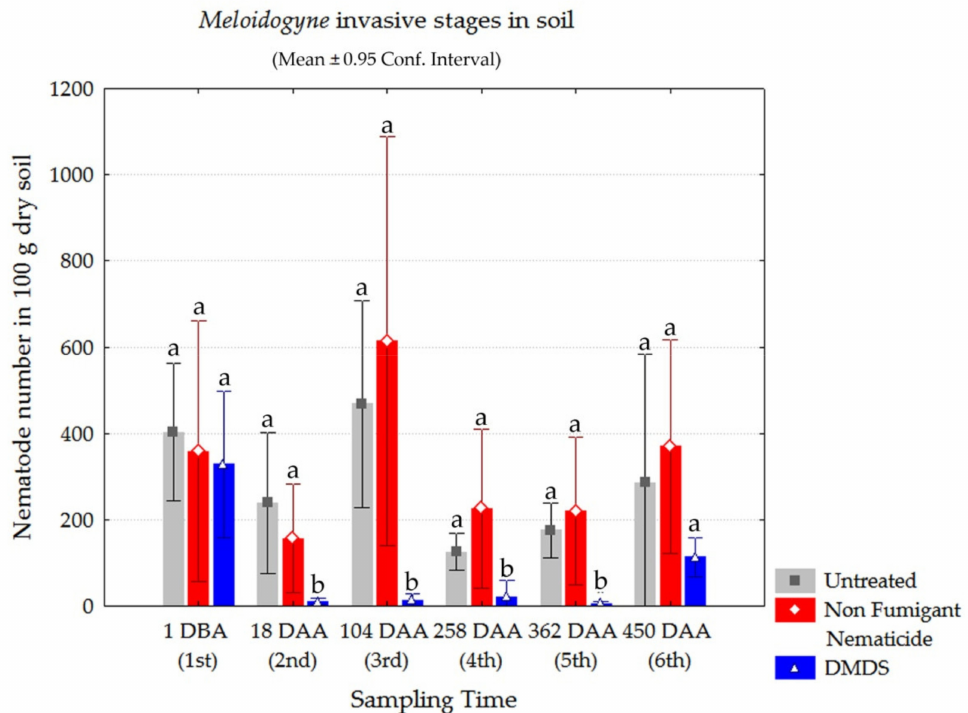
Figure 1. Dynamic of root-knot nematode second stage juveniles (J2) in the soil during the whole study period (DBA days before and DAA days after application of DMDS); Statistical significance of the differences between variants and treatments after Tukey’s test ( p < 0.05) was marked with different letters. Table 3. Efficacy of the treatments in controlling the root-knot nematode ( M. arenaria ) and increasing yield of the first crop cucumber. Summer–autumn cycle (July–October 2018). Treatment (Nr.